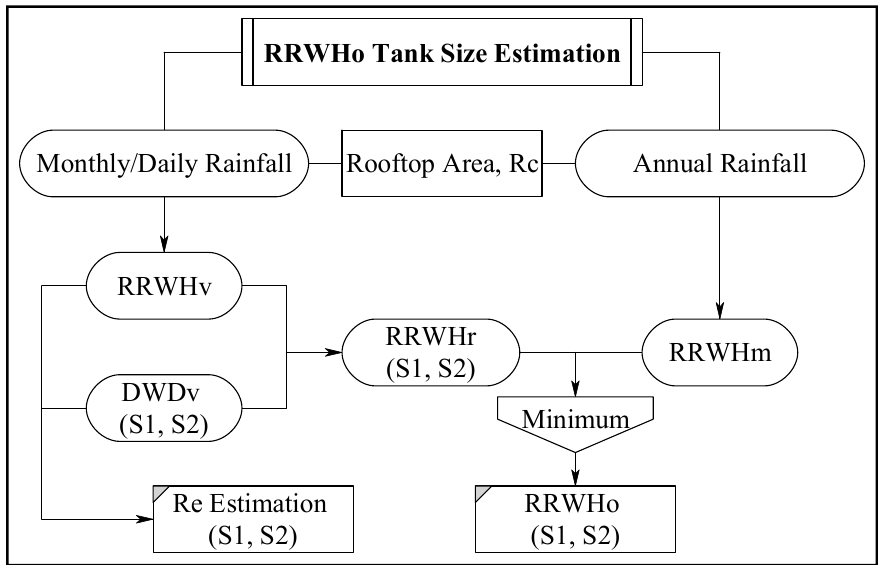
Figure 3. The overall methodological approach.